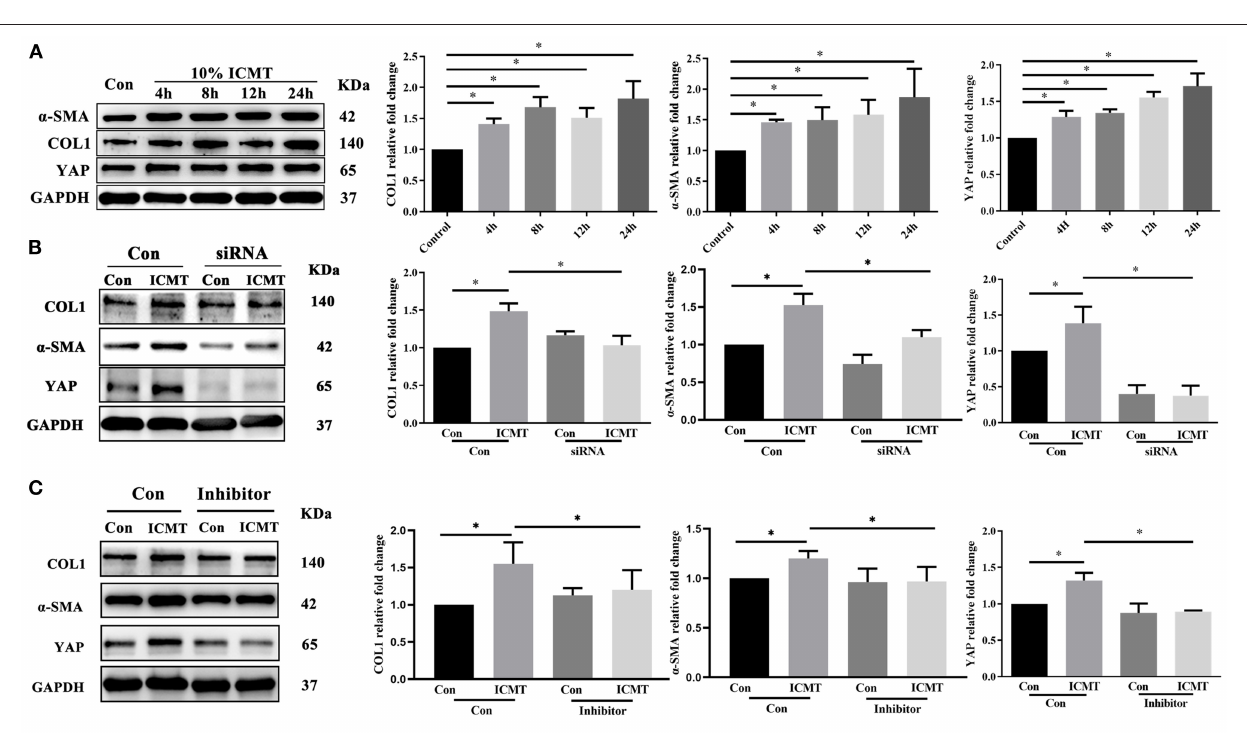
FIGURE 3 | YAP is involved in the regulation of myofibroblast differentiation induced by the mechanical strain. (A) Western blotting and quantitative analysis of YAP, COL1, and α -SMA under mechanical strain. HSF cultures without applying strain at 8h served as control groups. HSFs of the strain group were subjected to 10% cyclic strain at 0.5Hz for 4, 8, 12, and 24h. (B) Western blotting and quantitative analyses of YAP, COL1, and α -SMA in the YAP-specific siRNA and strain treatment groups. HSFs were transfected with the control siRNA (Con) or YAP siRNA (siRNA). HSFs of the strain group were subjected to 10% cyclic strain at 0.5Hz for 8h. (C) Western blotting and quantitative analyses of YAP, COL1, and α -SMA in the YAP-specific inhibitor and strain treatment groups. HSFs were transfected without (Con) or with verteporfin at 75 mg/ml (inhibitor). HSFs of the strain group were subjected to 10% cyclic strain at 0.5Hz for 8h. Data are presented as means ± SD of three separate experiments. ** P < 0.001. Abbreviations: Con, control; ICMT, intermittent cyclic mechanical tension; α -SMA, α -smooth muscle actin; COL1, collagen type I; GAPDH, glyceraldehyde 3-phosphate dehydrogenase.